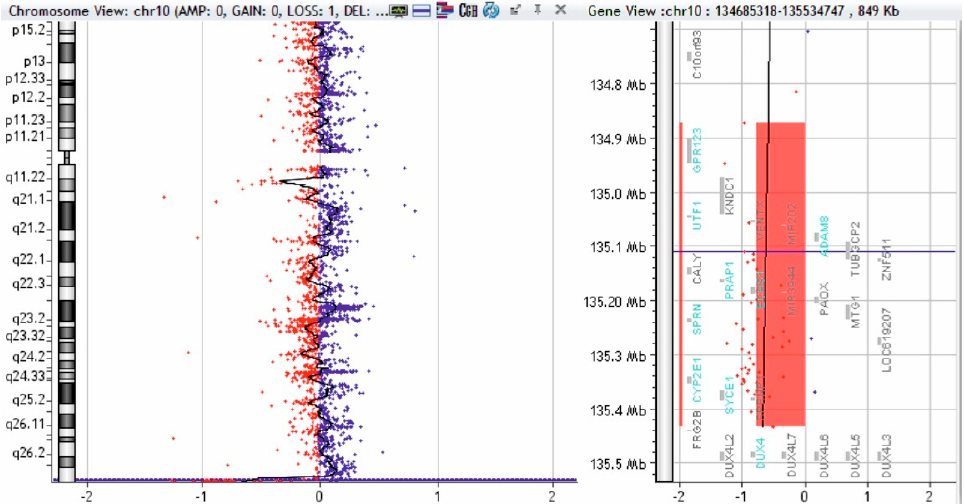
Figure 5. Array-CGH test of patient—microdeletion of 562 kb in the 10q26.3 region (shaded in red). Red and blue dots represent the log2 ratio of fluorescence (Cy5/Cy3), calculated by analytical software; log2 ratio at 1 indicates a duplication of the DNA of the region (3 copies) in the test sample versus the control (in blue color) and a log2 ratio at -1 indicates a deletion of the DNA of that region in the test sample versus the control (red deviation).